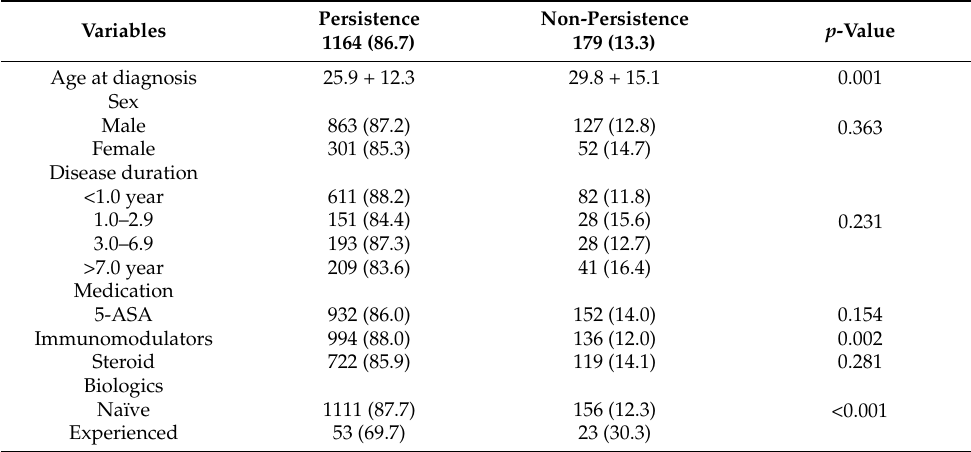
Table 2. Risk factors of non-persistence in infliximab group.